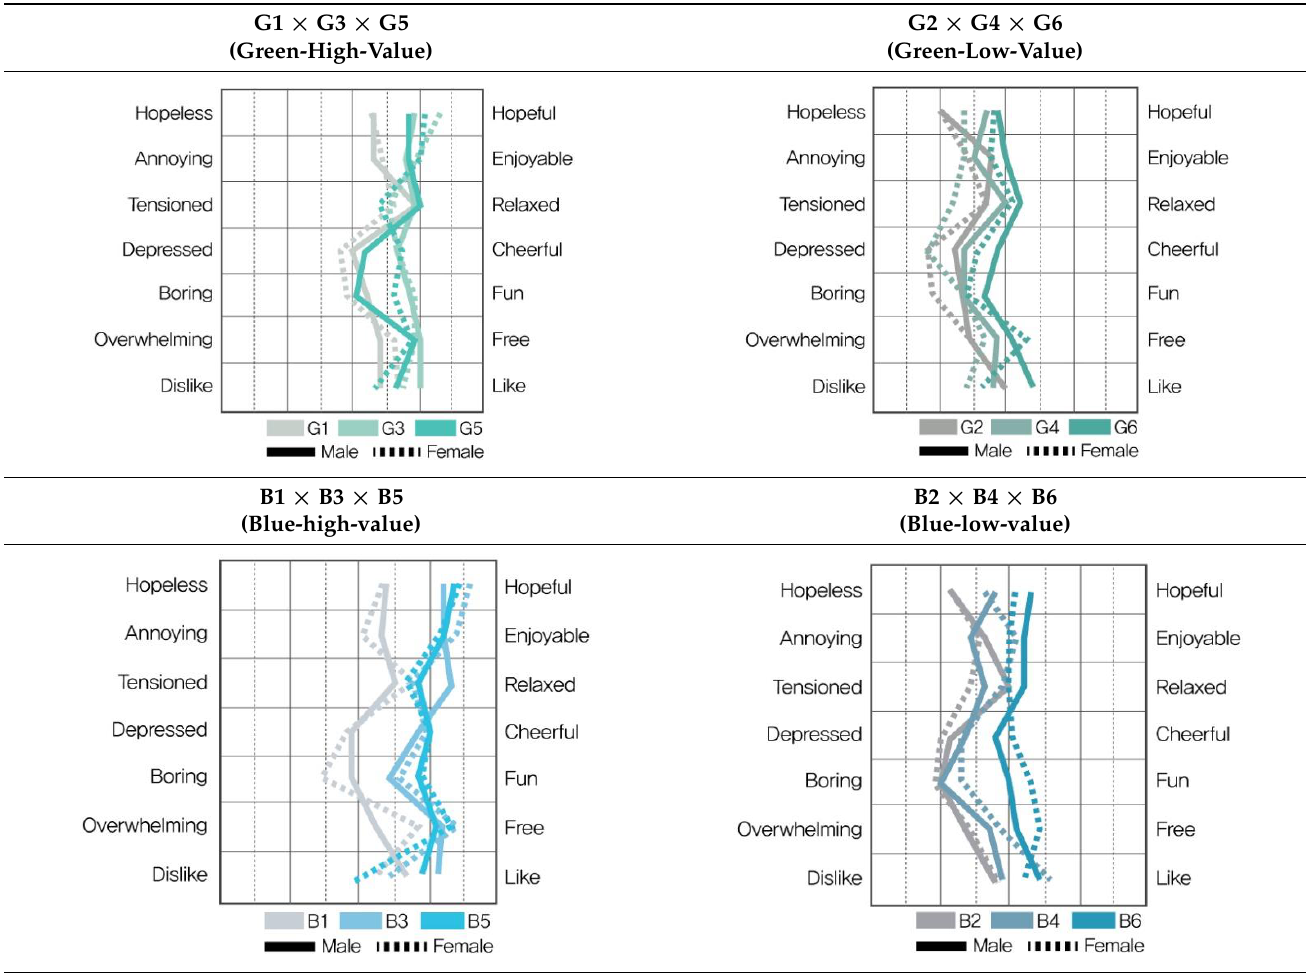
Table 9. Average values of stress assessment for males and females according to changes in environmental color chroma.